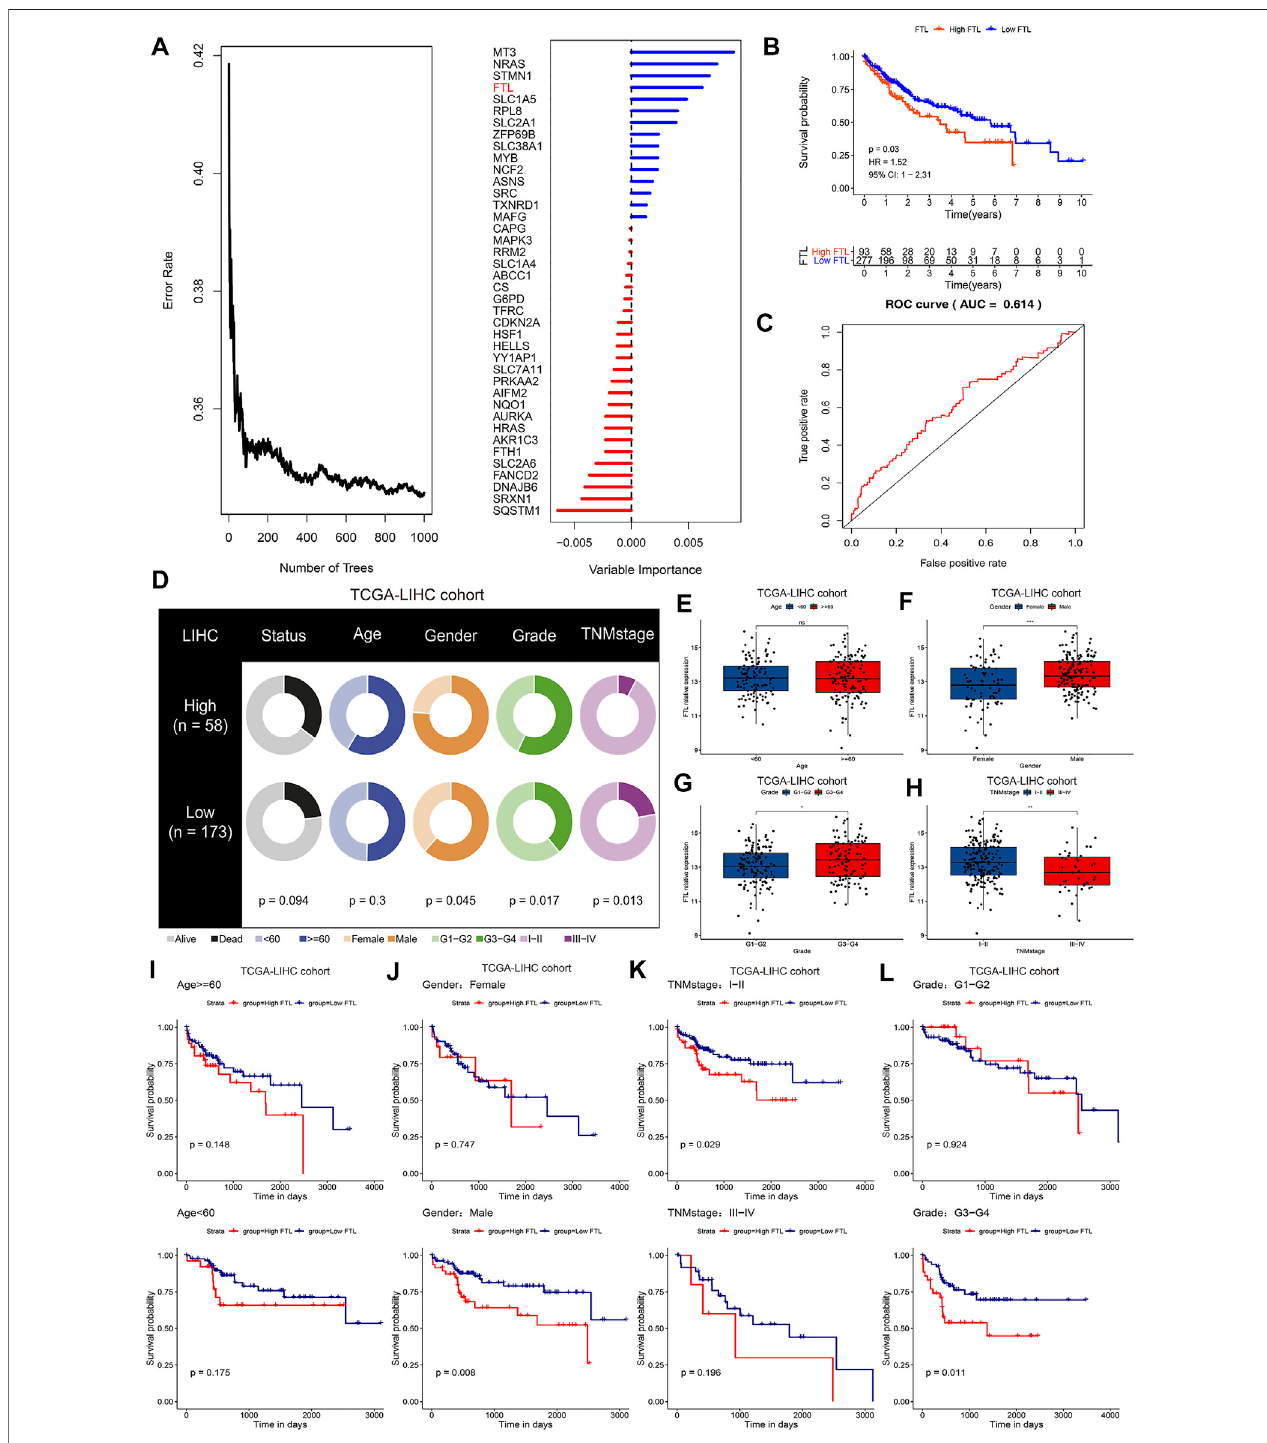
FIGURE 3 | FTL is a critical ferroptosis regulator associated with prognosis and clinical features in HCC. (A) Random forest analysis indicating the importance of ferroptosis regulators in predicting overall survival in HCC. (B) K-M survival curve showing the different overall survival rates in the high FTL and low FTL groups in the TCGA-LIHC cohort. (C) ROC curves evaluating the speci fi city and sensitivity of FTL in predicting overall survival in HCC. (D) Differences in clinical features, including survival status, age, sex, grade, and TNM stage, between the high FTL and low FTL groups in the TCGA-LIHC cohort. (E – H) Correlation of FTL expression and clinical features including age, sex, grade, and TNM stage in the TCGA-LIHC cohort. (I-L) K-M survival curveshowing the different overall survival rates ofpatients in the high FTL and low FTL groups in different clinical subgroups of the TCGA-LIHC cohort. ns, no signi fi cance. * p < 0.05, ** p < 0.01, and *** p < 0.001.